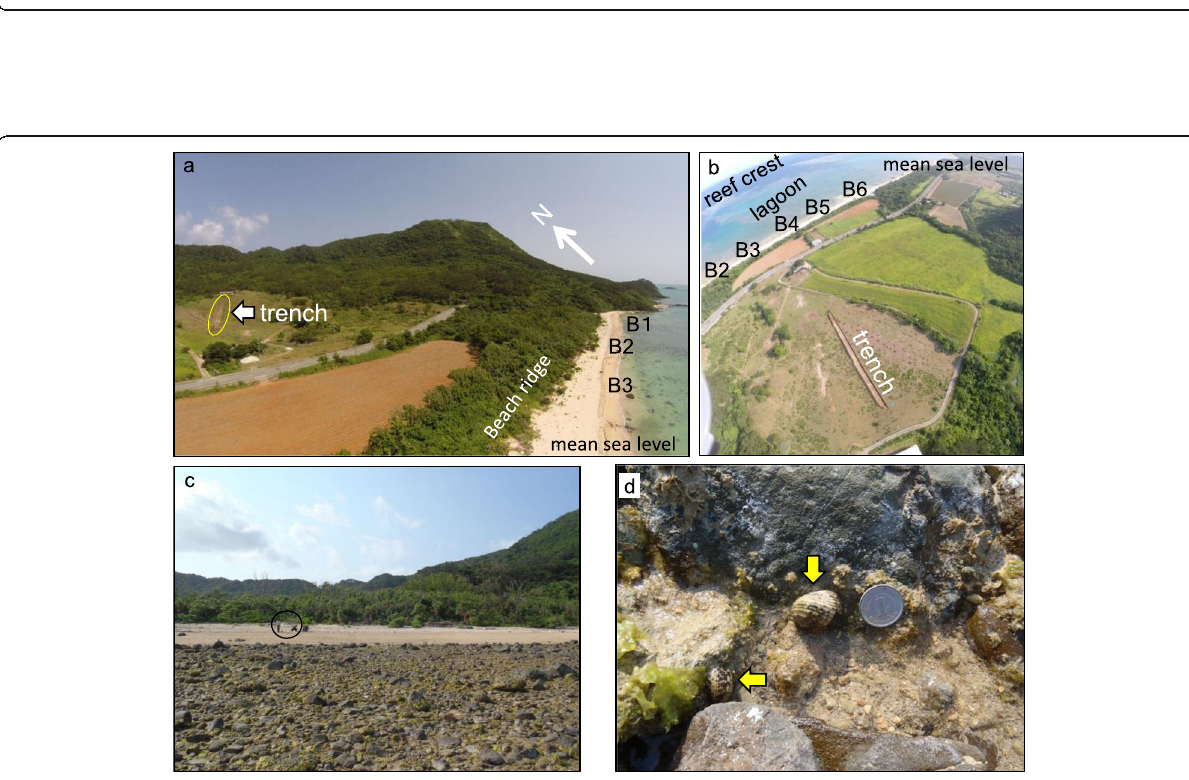
Fig. 2 a Photograph of the trench, showing sampling sites B1 – B3. b Photograph of the trench, showing sampling sites B2 – B6. c Photograph of the coastal area at site B2. The circle is around two persons. d Two Nerita squamulata individuals (arrows) at site